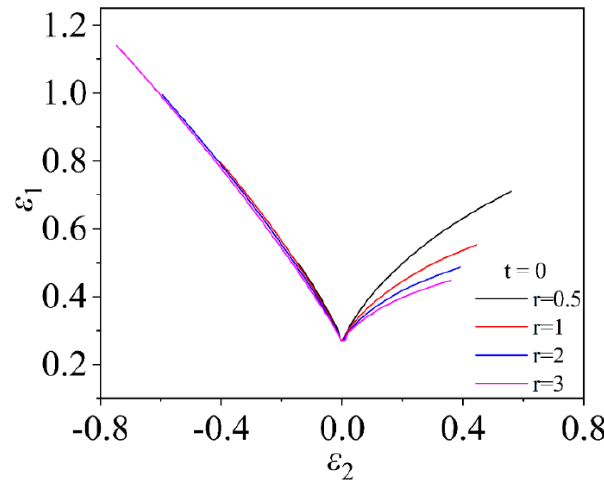
Figure 17. FLD for different r values based on C-H instability criterion and Hill48 yield criterion at t = 0.